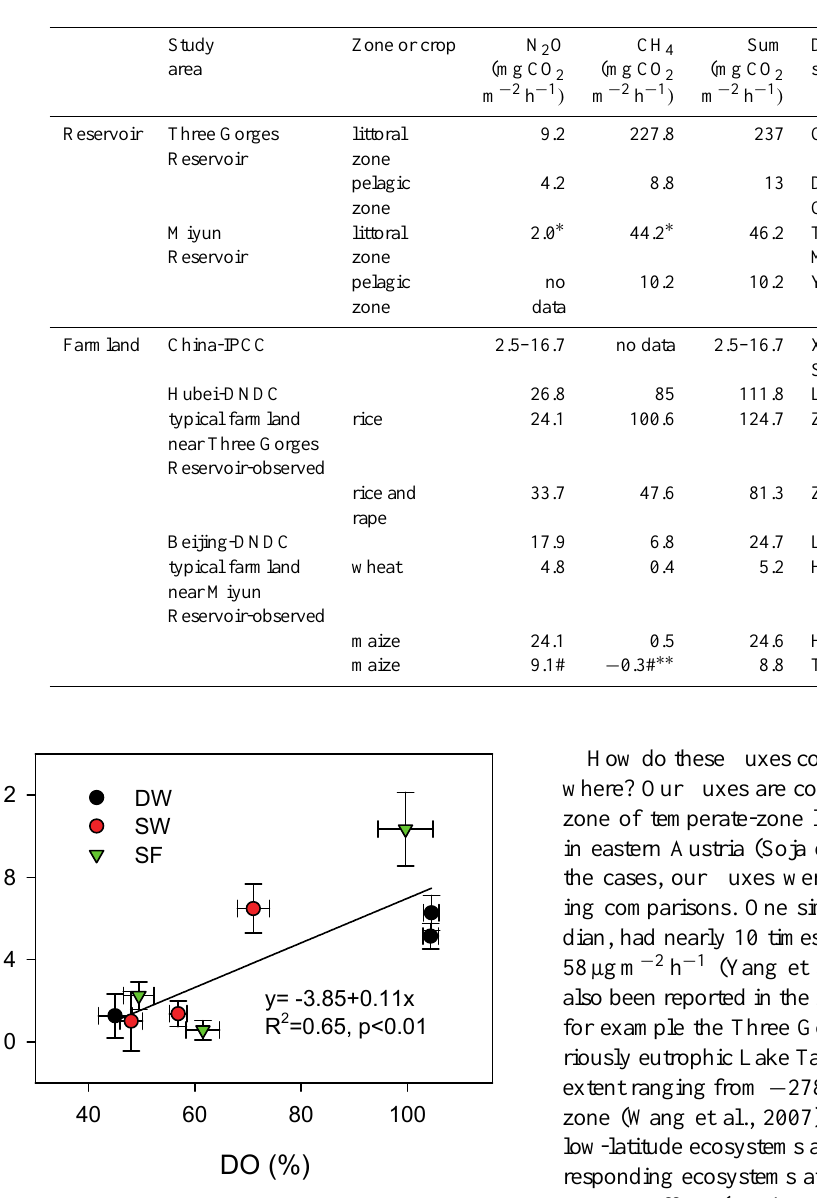
Figure 7. Relationship between flux and water DO (mean ± SE). DW: deep water site; SW: shallow water site; SF: seasonally